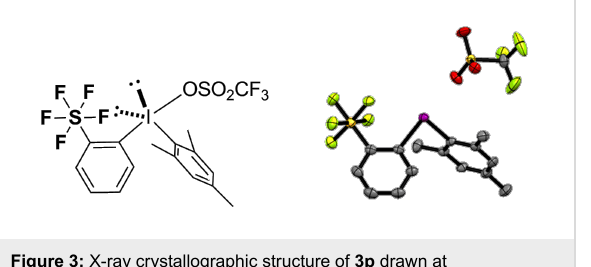
concentrations, i.e., 1 μ M and 5 μ M (Figure 2), 3m has a lower IC 50 value of 0.68 μ M than that of 3k (2.45 μ M), as evaluated by the MTT assay. The best potency and IC 50 value (0.49 μ M) was obtained for SF 5 type 3p , which is quite impressive when